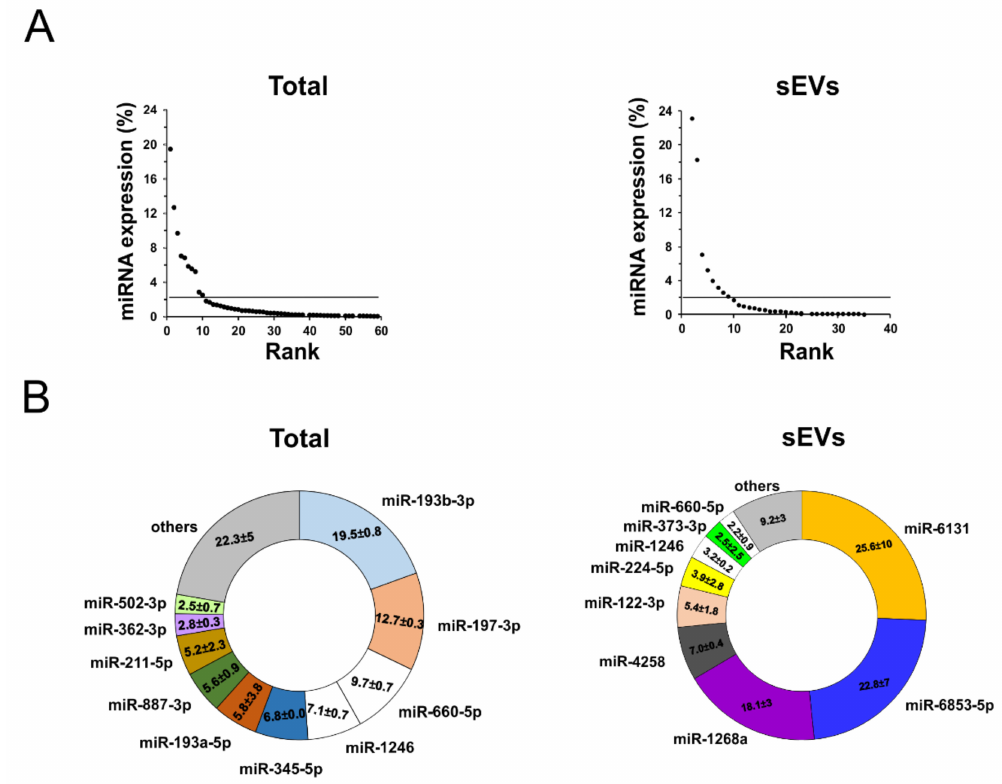
Figure 5. Human-specific miRNA abundance analysis in the mouse plasma. ( A ) Rank abundance curve of the human-specific miRNAs both expressed in the mouse total plasma (left panel) and enriched in the sEVs (right panel). The threshold was set at 2% of the miRNA expression (horizontal line). ( B ) The most abundant miRNAs are shown in the ring graph in both total plasma (left panel) and sEV (right panel) compartments. The number reported in each slice of the ring represents the percentage of expression of the indicated